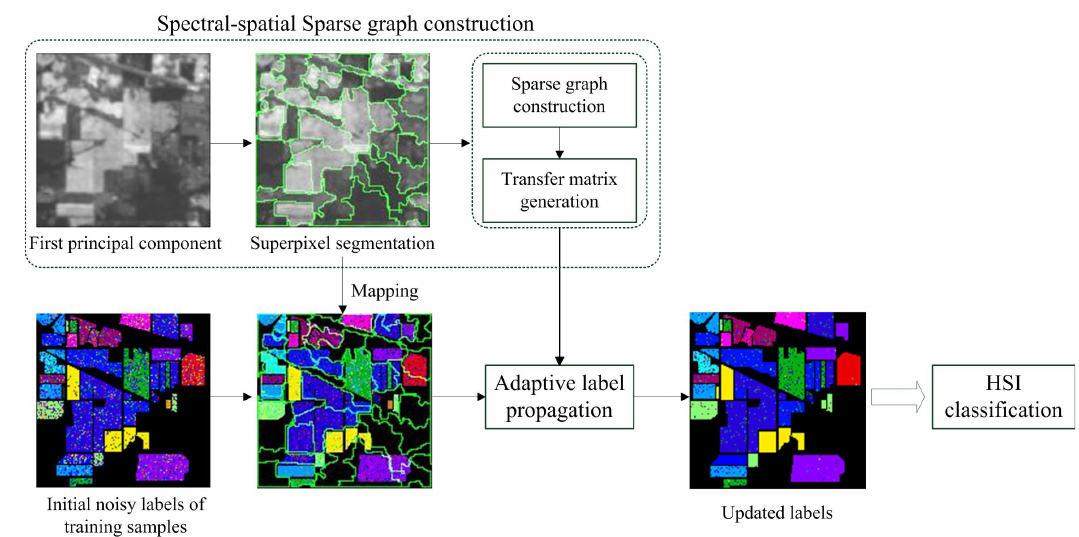
Figure 1. The framework of the proposed SALP algorithm , which mainly includes spectral–spatial sparse graph construction and adaptive label